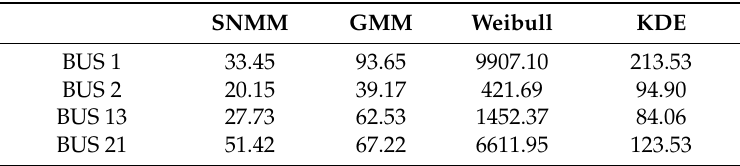
Table 2. Chi-square values of three models.